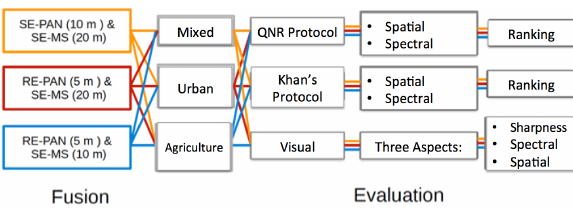
Figure 1. Experiments and test data - adapted from (Moellmann 2016)